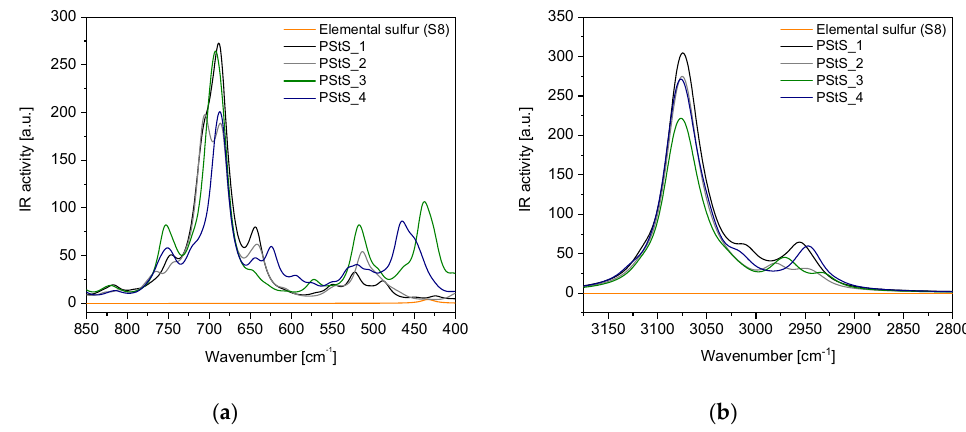
Figure 9. Calculated IR spectra of olisulfides with various lengths of sulfur bridges: ( a ) in the range characteristic for the polysulfide (-S x -) bonds, and ( b ) in the range characteristic for the C–S bonds. Comparing the absorption FTIR spectra of poly (styrene sulfide) and poly (StS/S 8 ) copolymers with poly (styrene), it is easy to detect the appearance of the new peak at around 720 cm −1 , which may be attributed to the C‒S bond in the linear structure of polysulfides [40]. This band occurs also in the FTIR spectra of all other polysulfides. Moreover, in case of poly (StS) and its copolymers with sulfur, the range below 540 cm −1 is rich in overlapped lines, due to the occurrence of diversified types of sulfide bonds in the macromolecules. Depending on the initial ratio of styrene sulfide to elemental sulfur and the copolymerization time, the number of sulfur atoms in the mer structure of synthesized polysulfides is different. This fact is confirmed by the various shapes, the number of maxima in the rage of 450–540 cm −1 and their relative intensity ratio. However, due to the fact that the sulfide bonds possess strong non-polar character, the changes are much clearly visible in the Raman spectra in the range of 380–540 cm −1 as described in Section 3.2.2. In the case of poly (StS) and poly (StS/S 8 ) copolymers, residual peaks along the particular spectrum are overlapping suggesting that the polysulfide macromolecules differ only in the number of sulfur atoms in their structure. The spectrum of synthesized poly (styrene sulfide) is also consistent with those presented by Aeiyach and Lacaze [16], and in this case the poly (StS) was obtained via anodic or cathodic electrochemical polymerization of 1 . In the case of IR spectroscopy studies, also good agreement between experimental and calculated data was observed. In the spectral region 400–600 cm −1 , as DFT calculations show, the line with maximum below 520 cm −1 should appear for poly (styrene oligosulfides). The position of this line relates to the length of the oligosulfide bridge, the longer the -S‒S- sequence, the lower is the band position. Also, the other trends observed in experimental results such as increase of low wavenumber shoulder accompanying the line at 700 and a new band at 720 cm −1 in IR spectra of poly (styrene oligosulfides) are justified by theoretical calculations. According to DFT calculations in the high frequency region of the IR spectrum, the presence of oligosulfide sequences in poly (styrene oligosulfide) mainchains should result in a discrete structure of bands related to stretching modes of aliphatic CH 2 and CH groups. This effect is well visible also in the experimental spectra—especially in the case of the poly (StS/S 8 )_1.0_4 sample. Comparing the FTIR spectra of synthesized polysulfides with the well-known FTIR spectrum of poly (styrene) [41], which constitutes the reference in our work, the CH 2 stretching modes of poly (St) are found around 2850 cm −1 and 2920 cm −1 , while the bending mode of CH 2 appears near 1450 cm −1 . In case of poly (StS) and poly (StS/S 8 ) copolymers the bands corresponding to the CH 2 stretching modes exhibit significantly weaker IR absorptions comparing to the poly (styrene), while the bending mode of CH 2 is also noticed at around 1450 cm −1 . The absorption of the lone CH group in the bending mode appears in poly (styrene) in the approximate region of 1250–1380 cm −1 [41], particularly at 1375